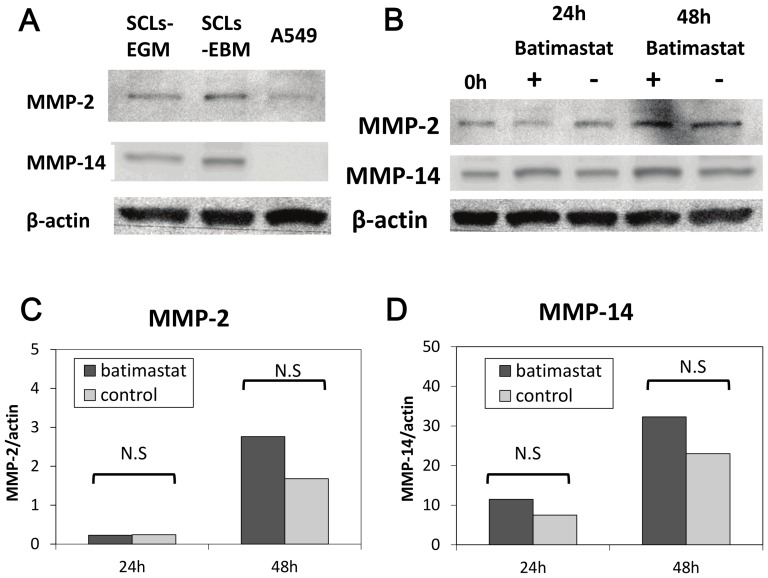
The results of the Western blot analysis.(A) The Western blot analysis revealed that the MMP-14 protein expression in SCLs was higher than that in A549 cells. There was no significant difference in the protein expression of MMP-14 in SCLs incubated in the media with or without growth factors. (B) Batimastat did not suppress the SCLs' expression of the MMP-14 and MMP-2 proteins. (C)(D) The band signal strength of MMP-14 (c) and MMP-2 (d) expressed as a ratio to beta-actin. No significant differences in the signal strength were recognized 24 hours and 48 hours after batimastat exposure between the batimastat and control groups. (“N.S.” showed no significant difference between two groups analyzed by Student's t-test.)